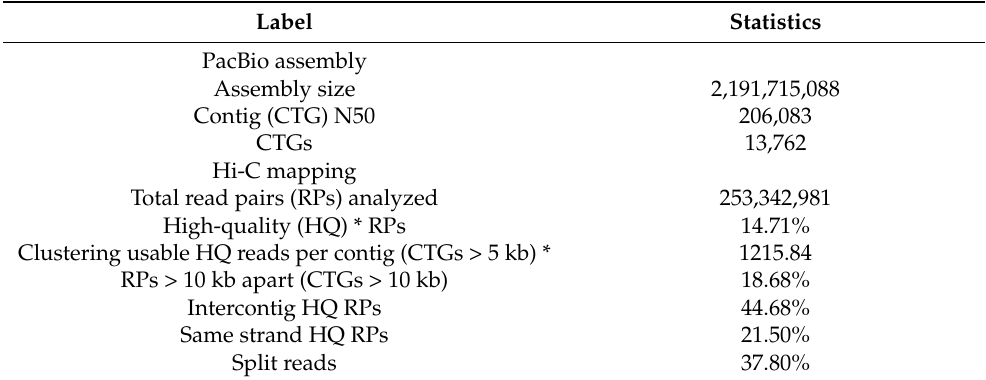
Table 2. Genome assembly statistics using HiFi reads and proximity ligation analysis for Mytilus chilensis .